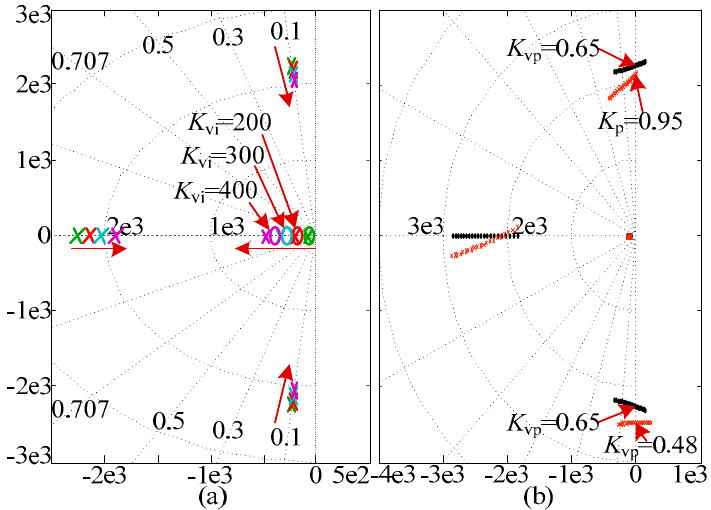
Figure 8. Zero and pole distribution diagram of voltage closed loop without resonant controller. ( a ) Increase of integral coefficient; ( b ) Increase of proportional coefficient when integral coefficient is 200.